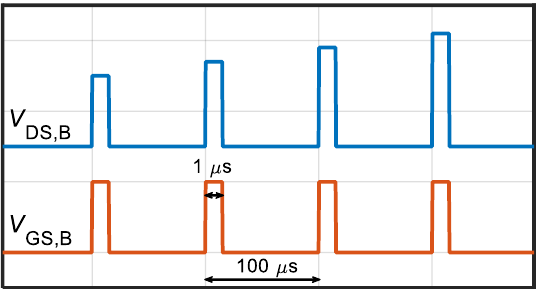
Figure 2. Illustration of signal waveforms employed during the pulsed I-V characterization. Short (1- µ s) pulses were synchronously applied at the drain and gate terminals from the respective reference baseline ( V DS,B and V GS,B ) with duty cycle 1%. The I-V curves were acquired from four different baselines, see Figure 3.